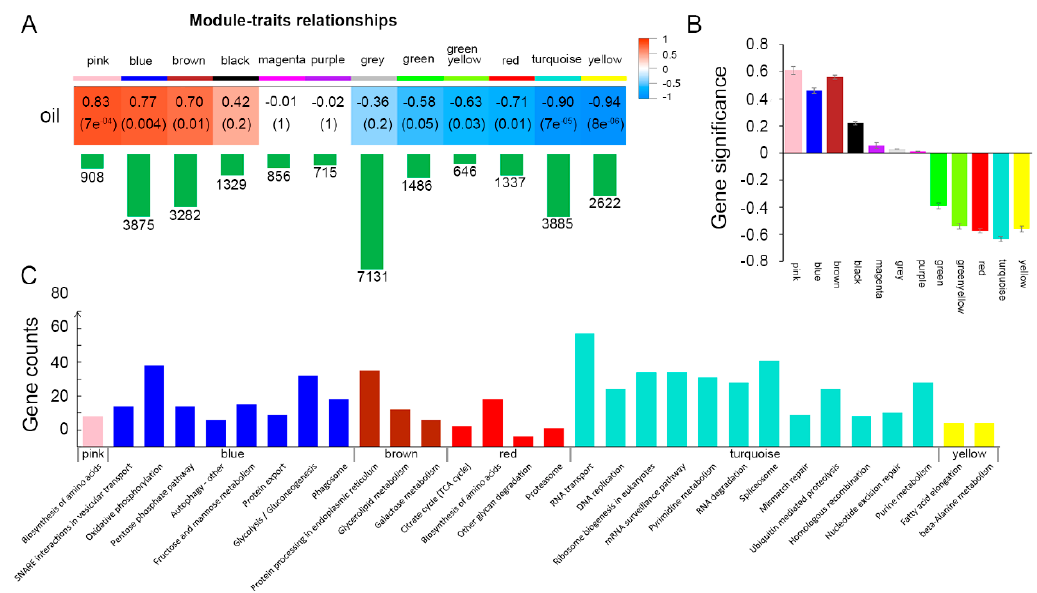
Figure 5. Correlation between gene co-expression network and oil content in developing soybean seeds. ( A ) The correlations between gene co-expression modules and oil content. The first colored row represents the modules detected by Weighted Correlation Network Analysis (WGCNA), and the colored cells below represent their correlations with oil content. The corresponding correlation coefficient (top) and P value (bottom) are displayed in each cell. The cells are color-coded by the correlation coefficient ( r ) as shown by the color key on the right. Red represents positive correlation while blue represents negative correlation. The green bar below each module represents the number of genes in each module. ( B ) Bar plot represents the average gene significance for each detected module. ( C ) Enriched pathways in genes of pink, blue, brown, red, turquoise and yellow modules, respectively. The x-axis shows the names of the pathways, and the y-axis displays the gene numbers in each pathway.